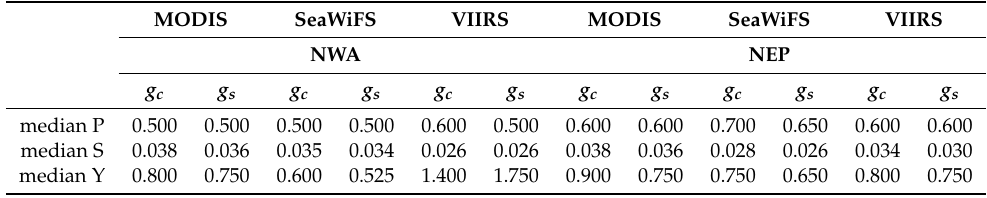
Table A9. Exponents used in Equations (6) and (10), where the g c columns give exponents optimized to the original constant g 1 and g 2 coefficients, and g s columns give the exponents optimized for the use of the spectral g coefficients g 1 , g 2 , and g 3